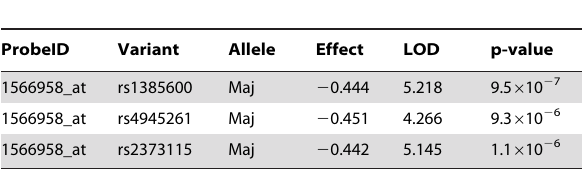
Table 6. GAB2 variants are associated with GAB2 mRNA expression in lymphoblastoid